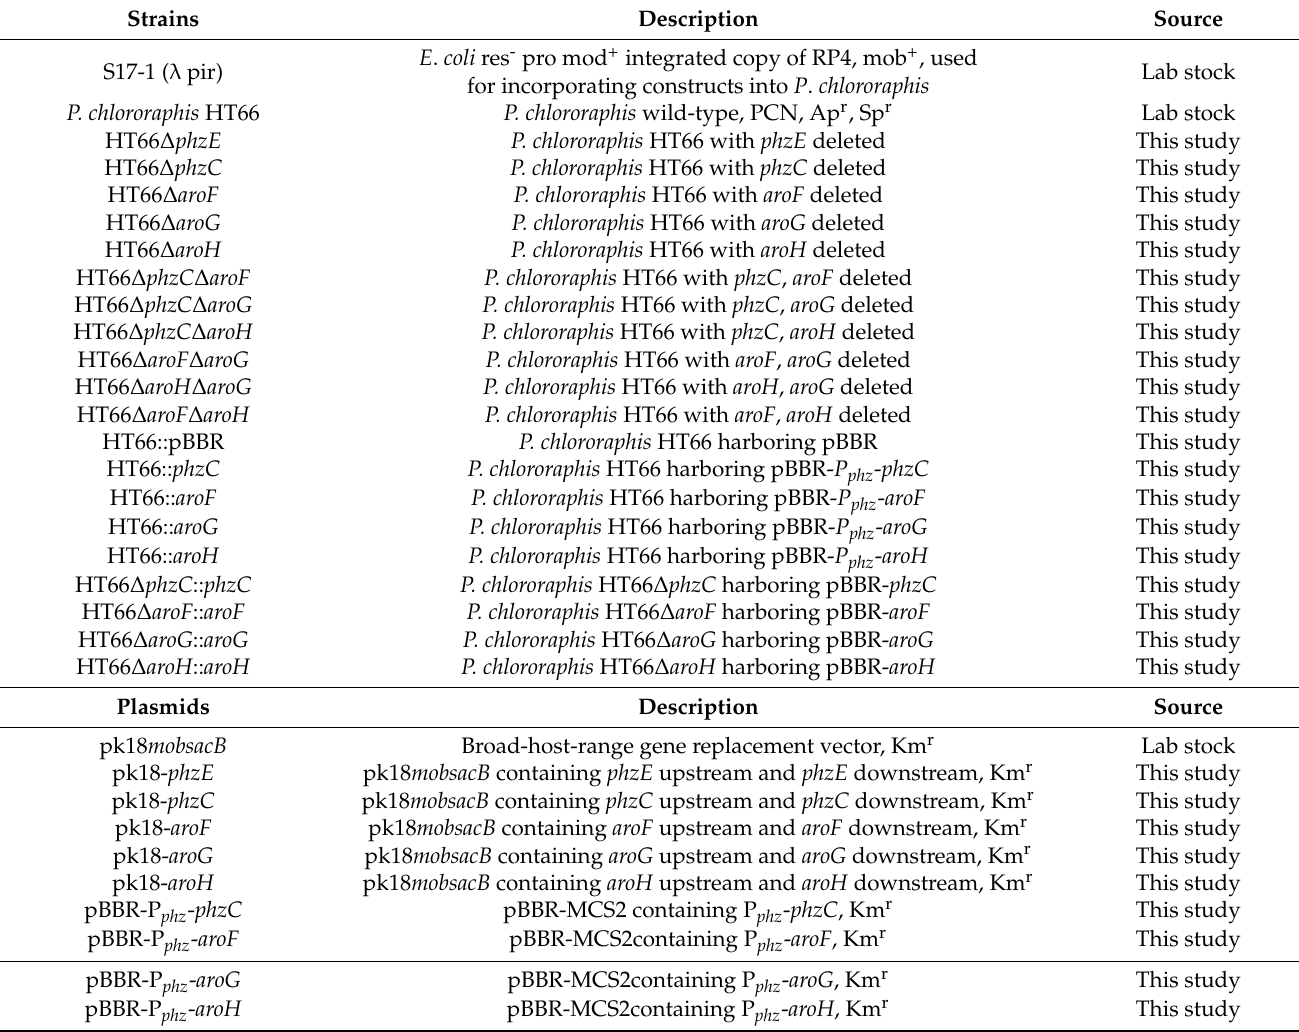
Table 1. Main strains, plasmids used and developed in this